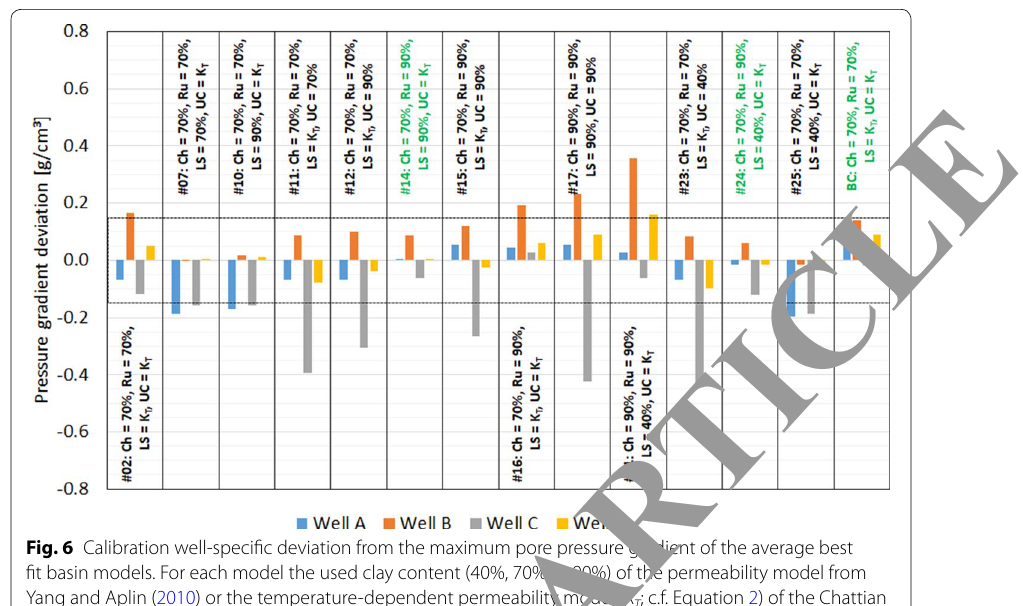
Fig. 6 Calibration well-specific deviation from the maximum pore pressure gradient of the average best fit basin models. For each model the used clay content (40%, 70% or 90%) of the permeability model from Yang and Aplin (2010) or the temperature-dependent permeability model ( K T ; c.f. Equation 2) of the Chattian (Ch), Rupelian (Ru), Lattorf/Sannoisian (LS) and Upper Cretaceous (UC) are specified. The black-dotted box indicates the acceptable pressure gradient deviation of 0.15 g/cm 3 . The numbers mark the model number used in Table 4. Model descriptions highlighted in green indicate models which yielded acceptable pore pressure deviations at the calibration Wells